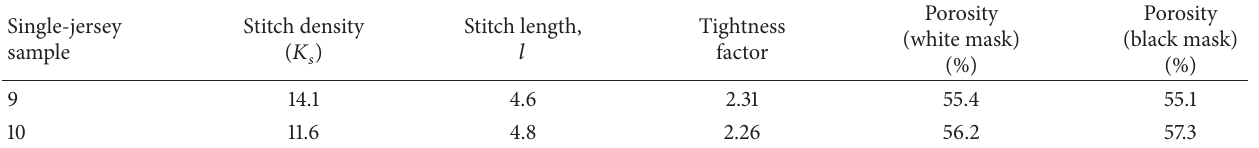
Table 5: Fabric features knitted for testing and validation (CKM